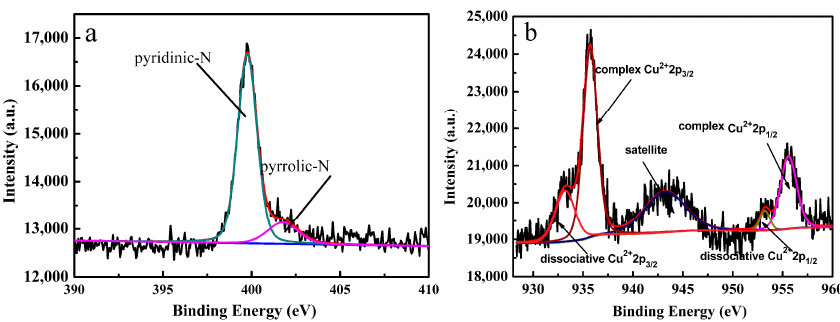
Figure 3. X ‐ ray photoelectron spectroscopy (XPS) spectra of N 1s ( a ) and Cu 2p ( b ) for Cu ‐ SOCBP/C.